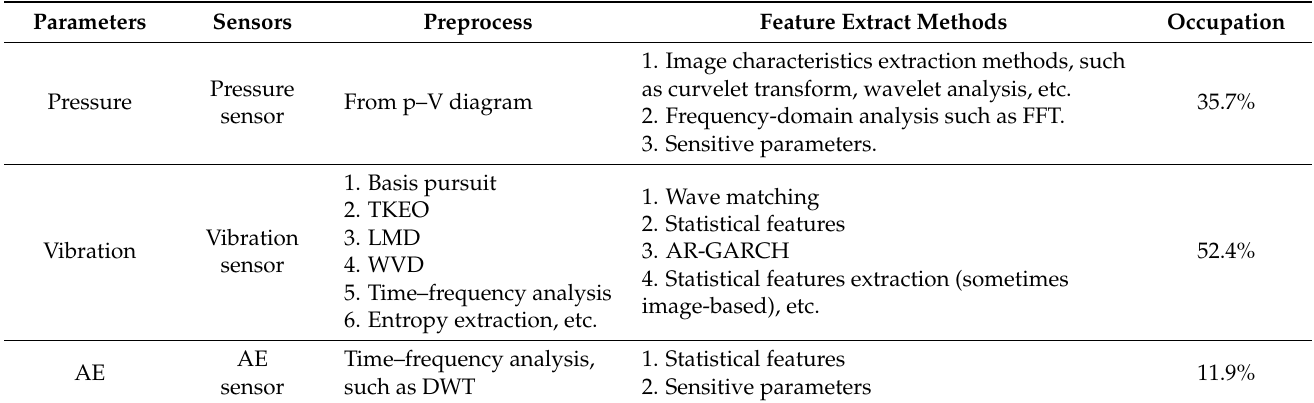
Table 2. Categories of main monitoring parameters in RC fault